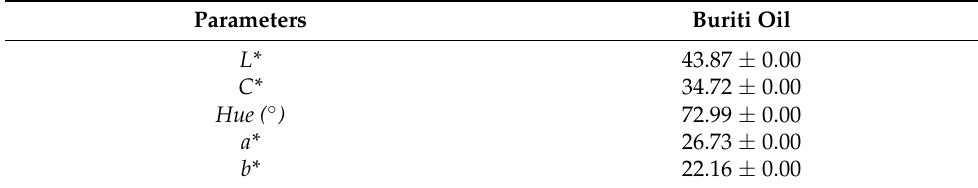
Table 5. Colorimetric parameters of buriti